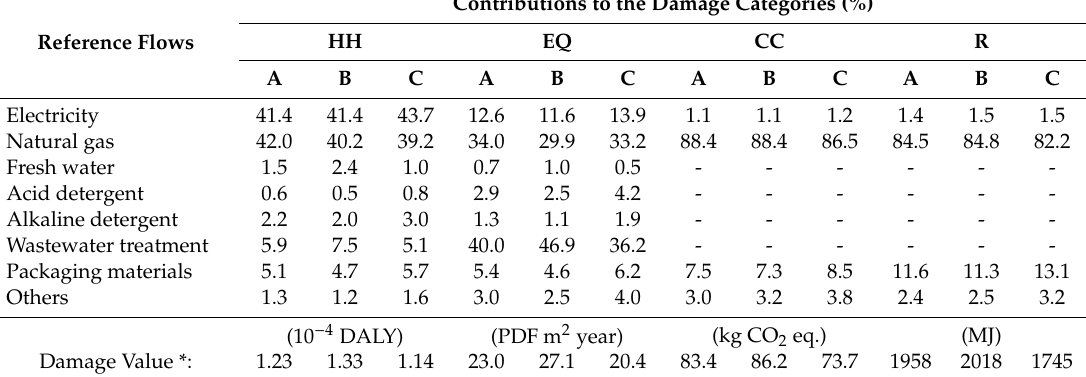
Table 8. Contributions of the reference flows to the damage categories of the processing stage for scenarios A, B, and C.